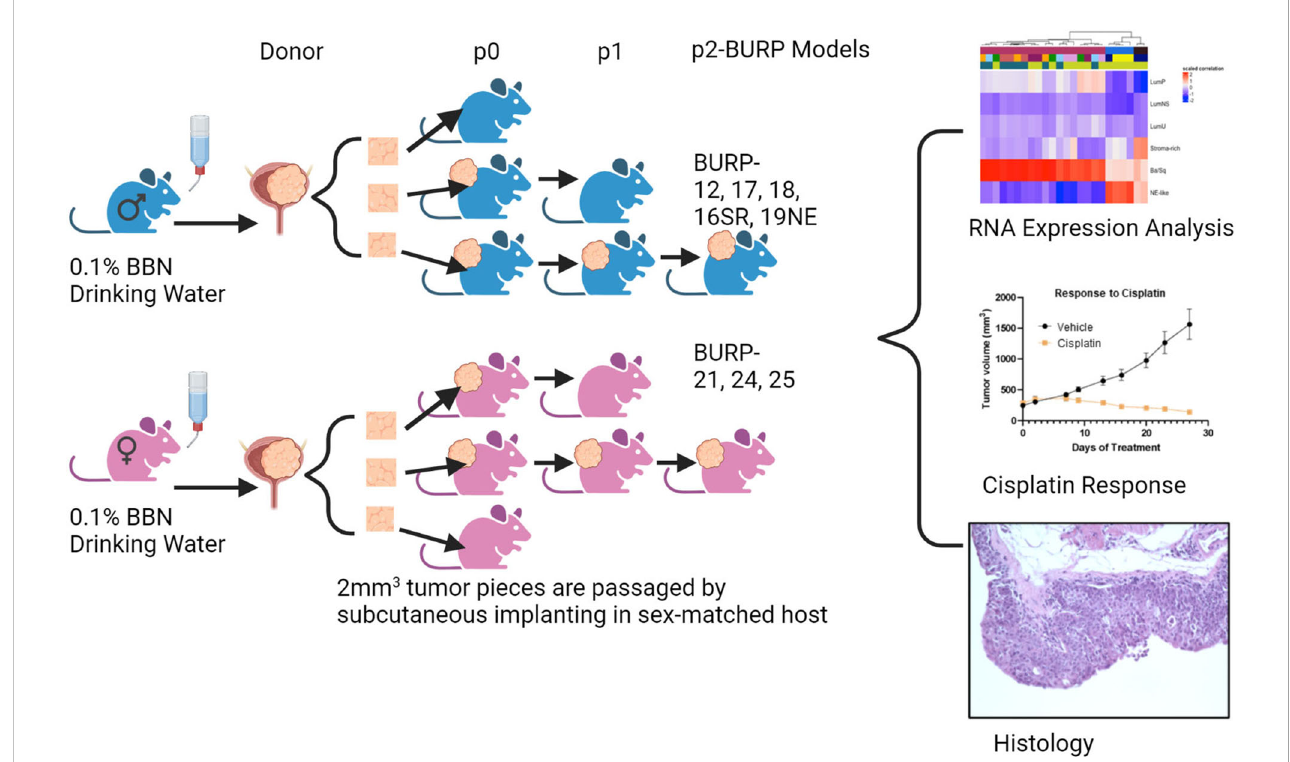
FIGURE 1 Graphical representation of methods. Created in